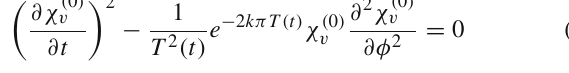
Fig. 6 χ ( 0 ) v vs ˜ t